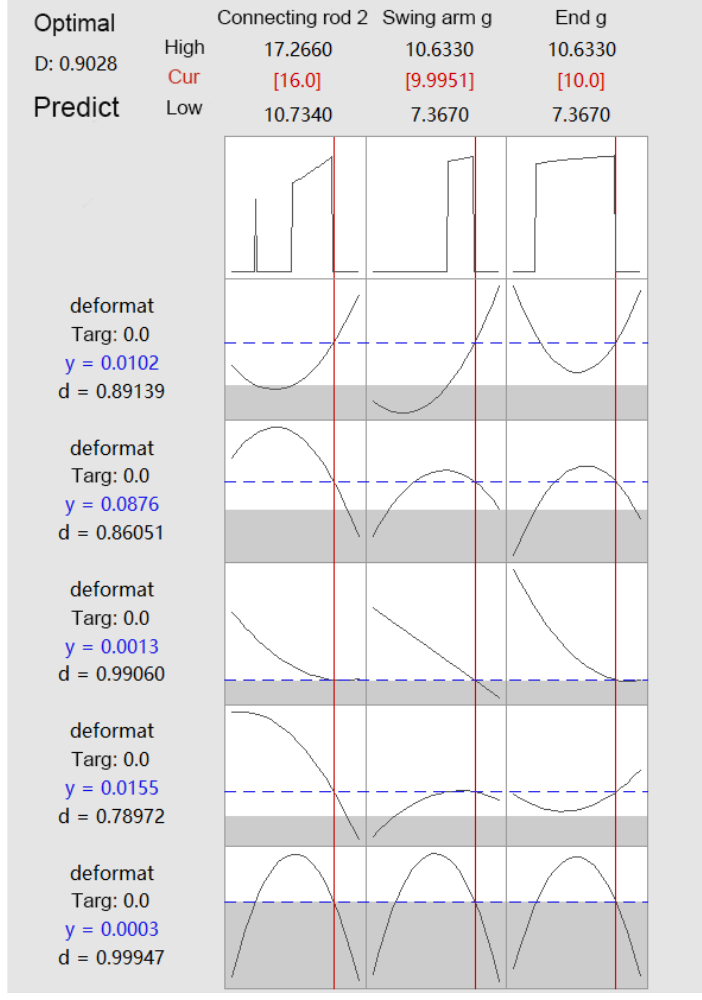
Figure 17. Optimization diagram of bar thickness design. Table 6. Response optimizer optimization results of bar thickness design.